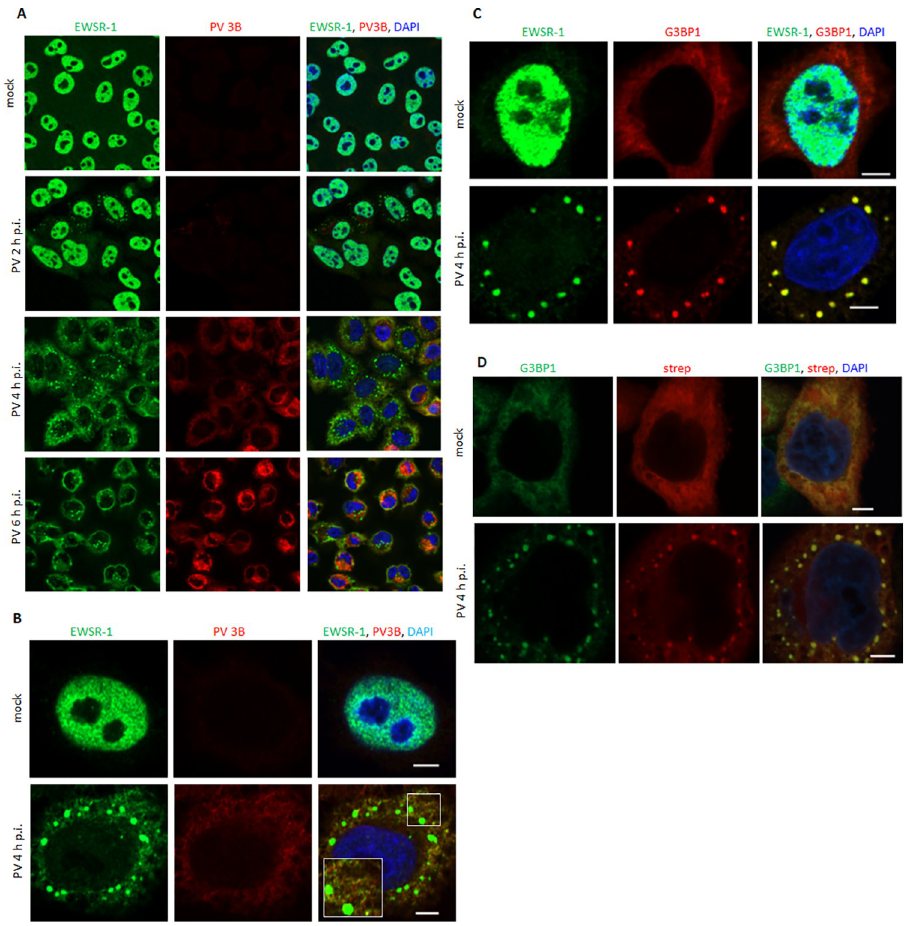
Fig 7. Cytoplasmic translocation of EWSR1 and its association with stress granules upon poliovirus infection. A. Confocal images of HeLa cells infected (or mock-infected) with 10 PFU/cell of poliovirus, fixed at 2, 4 and 6 h p.i and stained with antibodies against EWSR1 and the viral replication antigen 3B. B. High magnification confocal images of HeLa cells infected (or mock-infected) and processed as in A at 4 h p.i. Note the association of cytoplasmic EWSR1 signal outside of stress granules with the 3B-positive structures. C. Confocal images of HeLa cells infected (or mock- infected) as in A, fixed at 4 h.i. and stained with antibodies against EWSR1 and the stress granule component G3BP1. Scale bar is 10 μ m. D. Confocal images of HeLa cells stably expressing APEX2-GARG-1060 infected (or mock- infected) as in A. C, and processed at 4 h p.i. to visualize biotinylated proteins and stained with antibodies to the stress granule component G3BP1. Scale bar is 5 μ